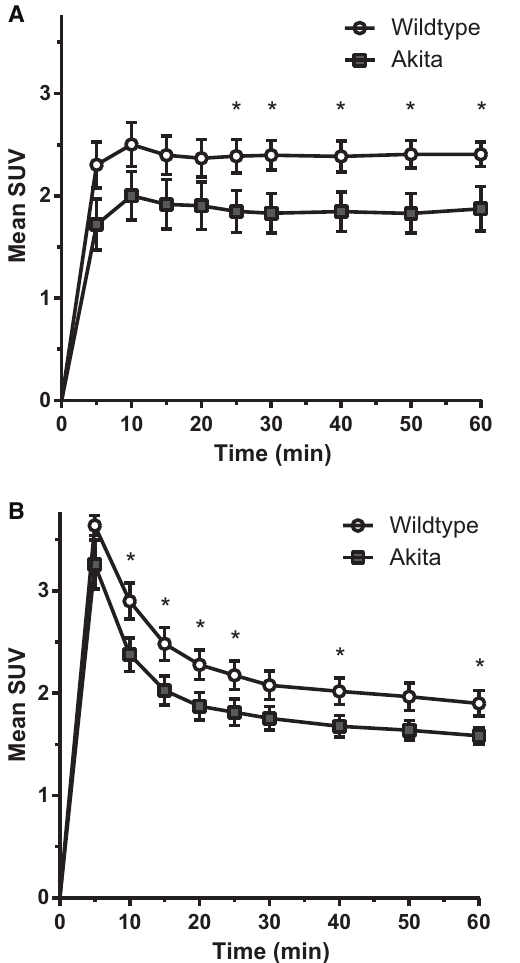
Figure 4. Time-activity curves (TACs) for 18 F-L-FEHTP uptake in the pancreas of a ) pancreas and b ) kidney of wt and Akita mice. TACs are expressed as SUVs from regions corresponding to regions of interest from six image slices corresponding to the areas of the kidneys and pancreas. Values are means ± SEM (n=6 for wt, n=5 for Akita). * p<0.05 compared to wt.